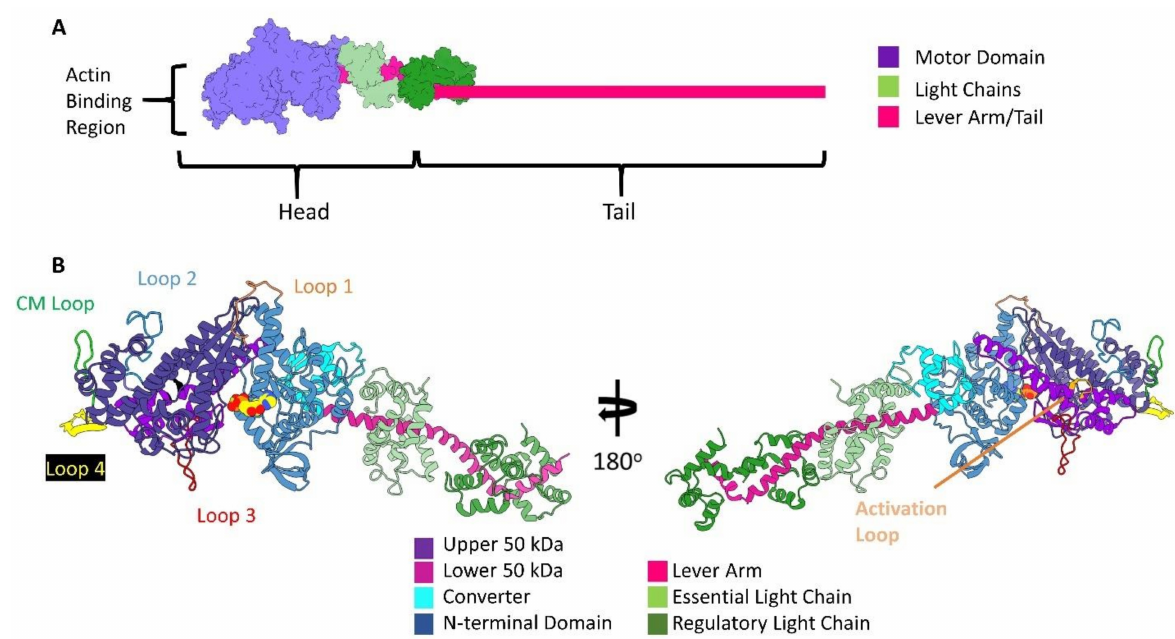
Figure 2. Structural organization of the myosin molecule. ( A ). Classical organization. The motor domain is colored in purple, the essential light chain in light green, the regulatory light chain in dark green, and the lever arm, which extends to the tail in pink. The actin-binding region is found in the motor domain. ( B ). Ribbon diagram of the myosin motor domain organization in two orientations. The secondary structure representation of the rigor skeletal muscle myosin II (PDB:5H53) [74] is colored by myosin subdomains. The surface loops of the molecule are also shown. Lastly, the nucleotide-binding site is specified with an ADP space-filling molecule. All figures rendered in